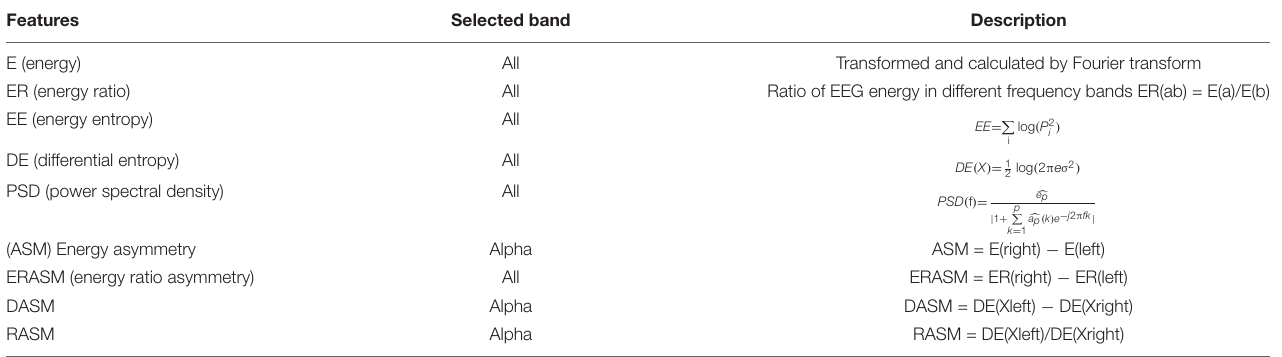
TABLE 2 | Selected